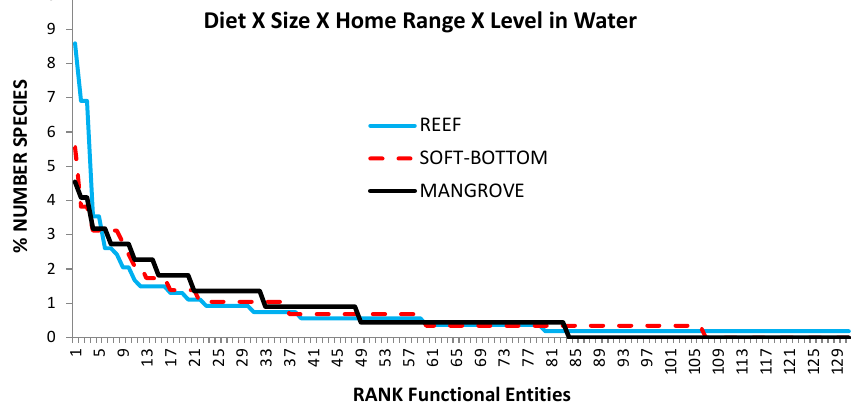
Figure 7. Redundancy within functional groups according to habitat and functional group type.